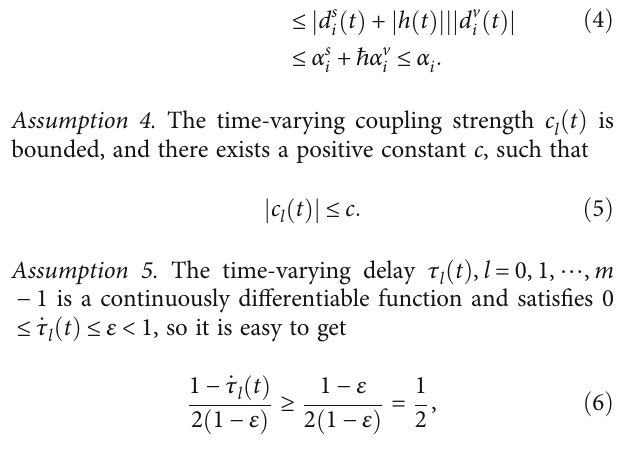
Figure 1: The nonlinear input ϕ